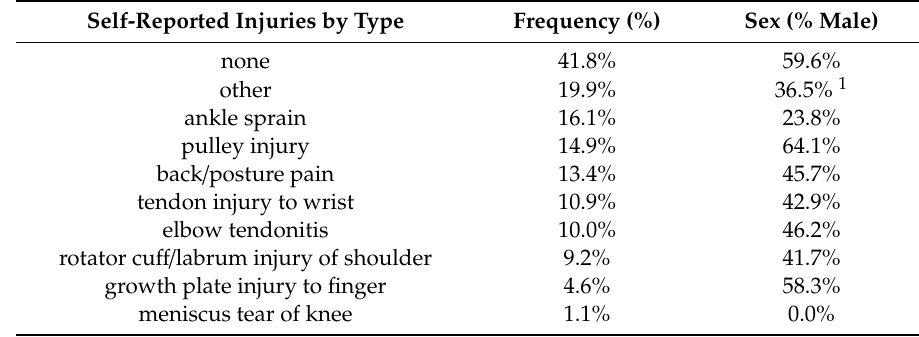
Table 1. Percentage of self-reported injuries by